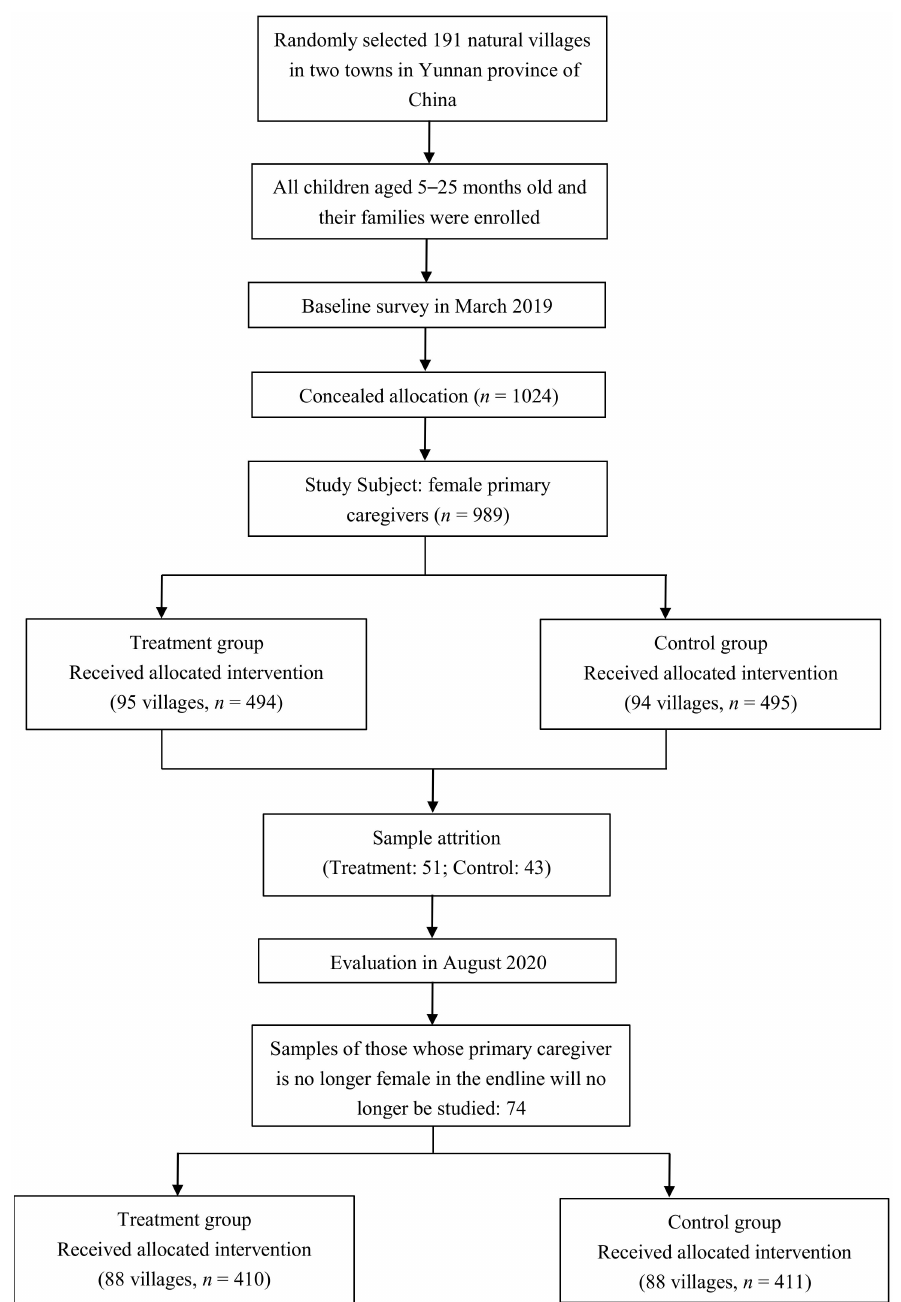
Figure 1. Flowchart of the parenting